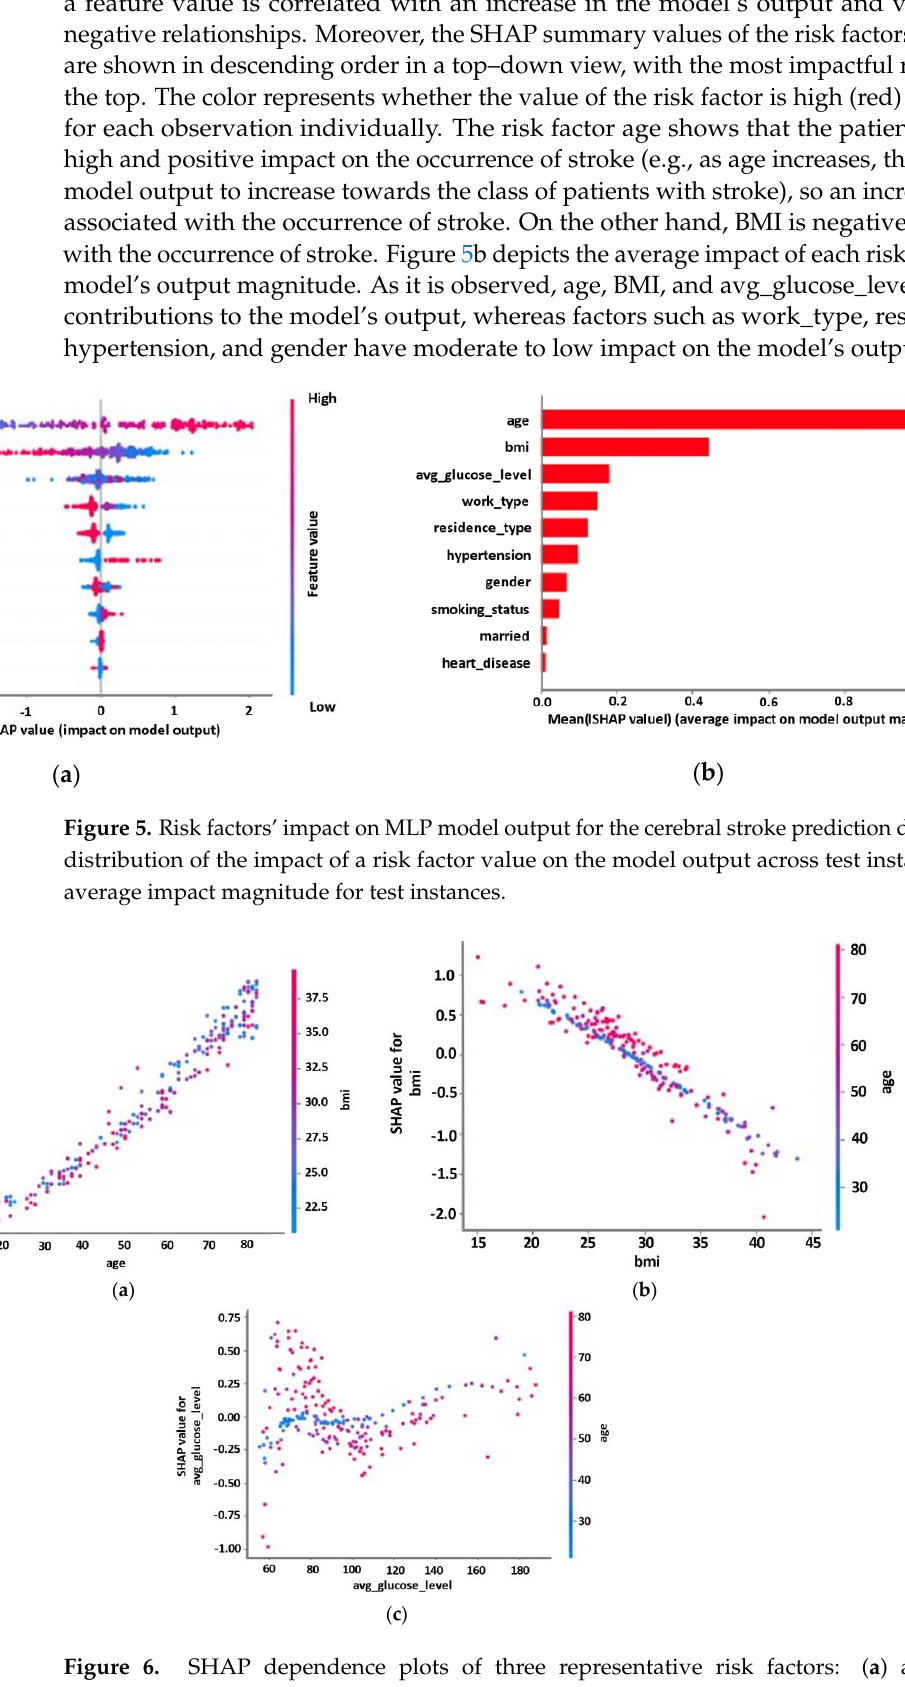
( b ) Figure 4. ( a ) Scatter plot of FP rate and FN rate . ( b ) Scatter plot of FN rate and G-Mean.